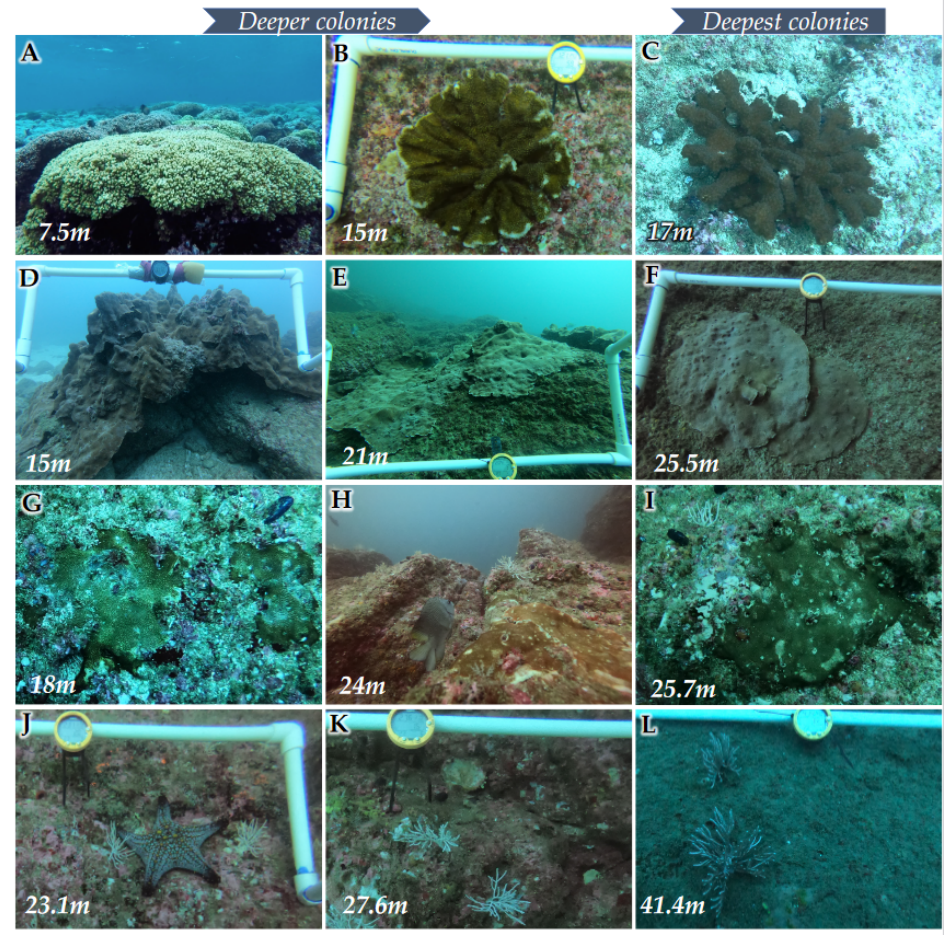
Figure 7. Variation in coral morphology with depth for: ( A – C ) Pocillopora ; ( D – F ) Pavona; ( G – I ) Porites panamensis ; and ( J – L ) Leptogorgia alba.